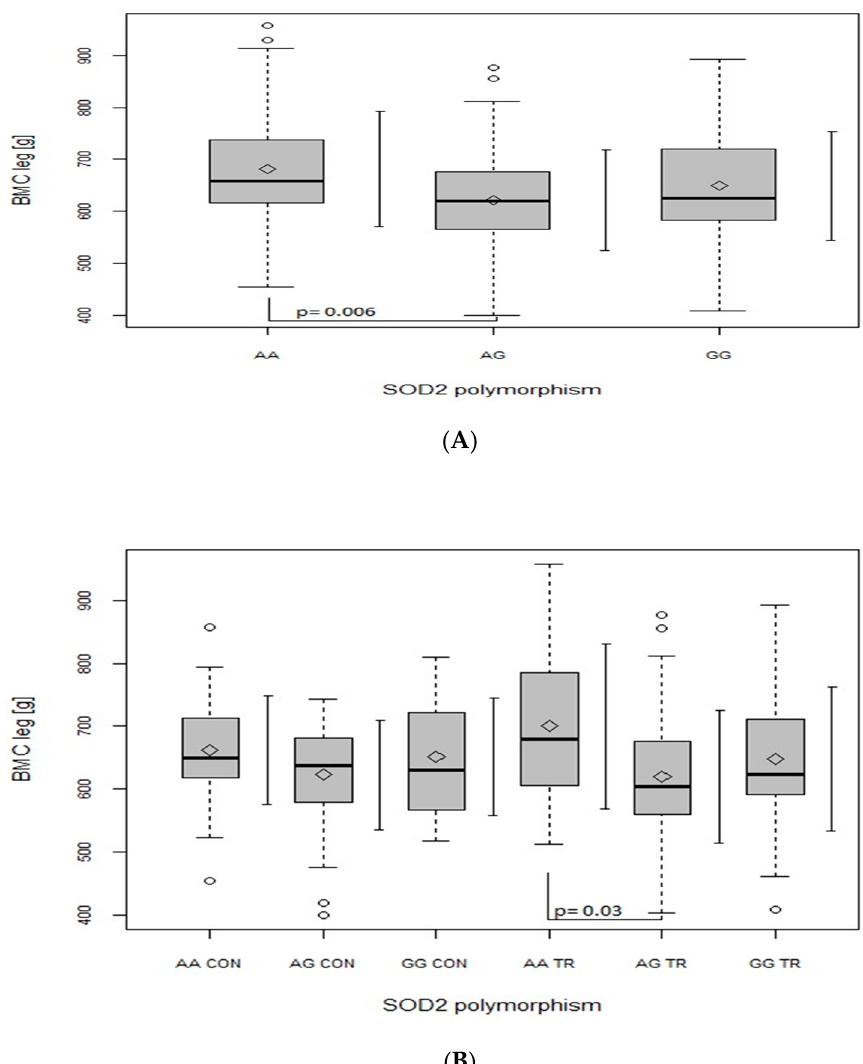
Figure 2. The effect of SOD2 polymorphism on bone mineral content (BMC) (g) of the leg. ( A ) In the whole group of studied participants; main effects: SOD2 ( p = 0.008; F = 4.99). ( B ) In control (CON) and trained (TR) group; main effects: SOD2 ( p = 0.008; F = 4.95). Key: ◊ —mean; ○ —outliers value; boxplots—median Q1–Q4 and mean ± SD.